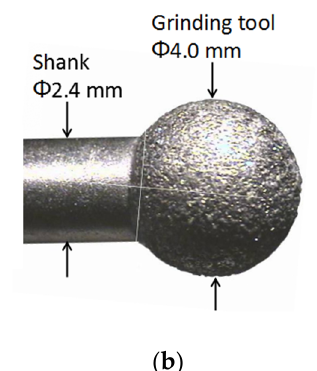
Figure 1. ( a ) The endonasal approach to the skull base. Reprinted from [1] with permission of Elsevier, and ( b ) spherical bone grinding tool. Reprinted from [2] with permission of Elsevier.